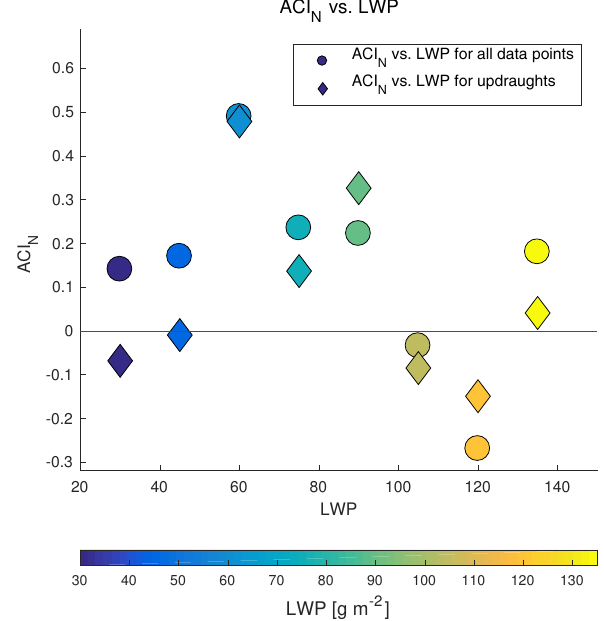
Figure 4. Scatter plot between ACI r and LWP for all data points and the data points located in the updraught areas in the aggregated data set.